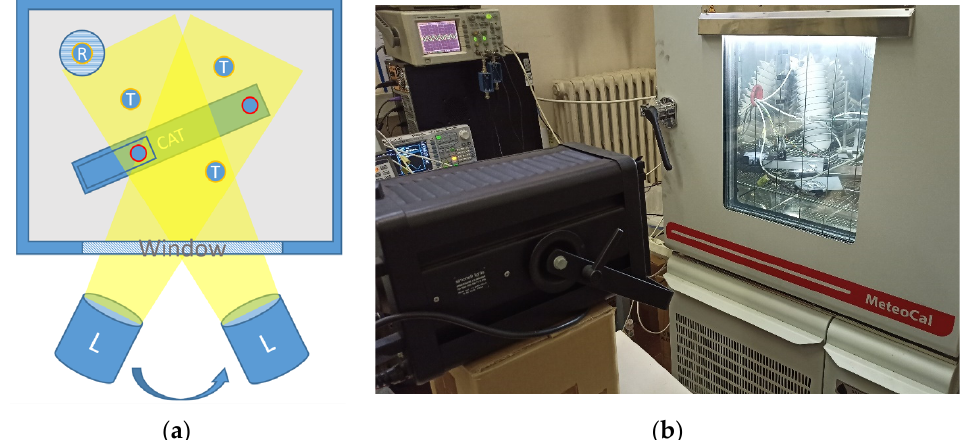
Figure 7. (a) : Scheme of the set ‐ up to check for the effect of irradiation where the lamp (L) is moved in different positions in front of the window. The marks T in the picture indicate the three naked Pt100, while the mark R stands for the radiation ‐ shielded Pt100. The red circles represent the transmitter and the receiver of CAT. (b) : A picture of the setup where the 1000 W halogen projector is visible in the foreground. On the right, the climatic chamber where the CAT and the thermometers are visible through the window.